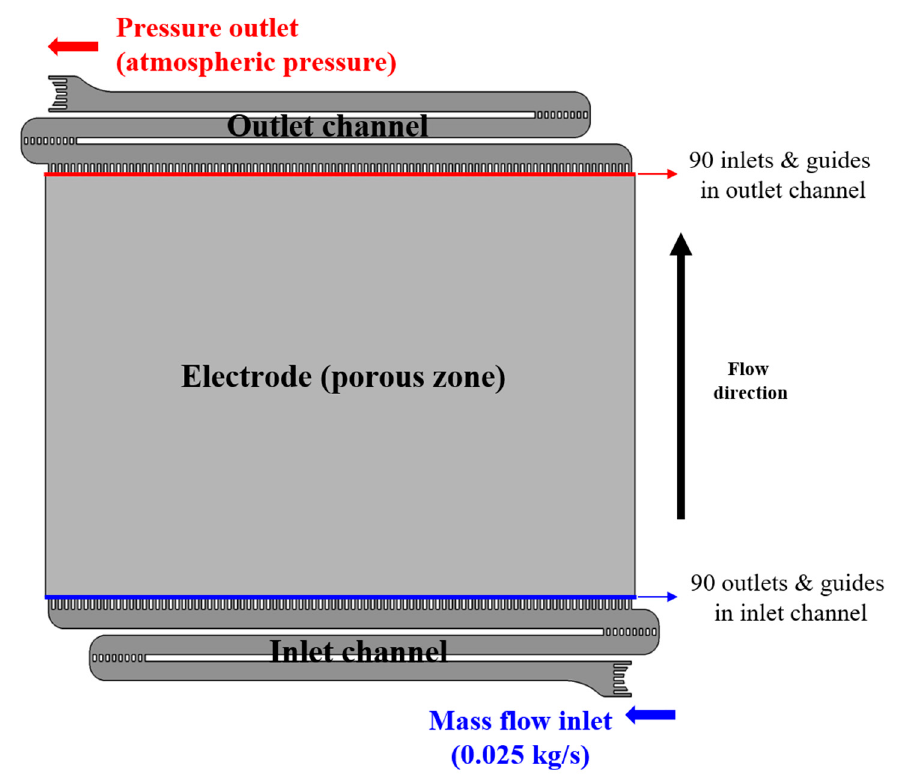
Figure 1. Computational domain for flow frame of vanadium redox flow battery.